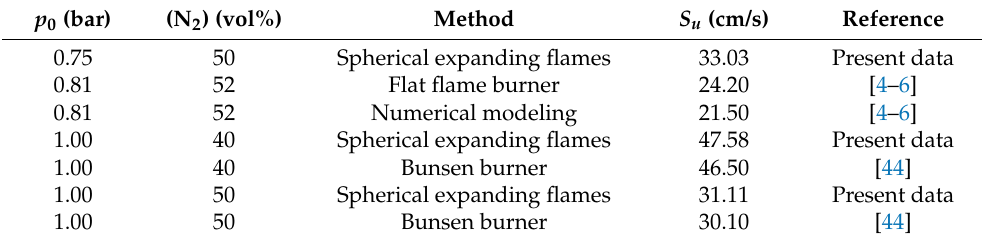
Table 1. Comparison between present data and data reported in the